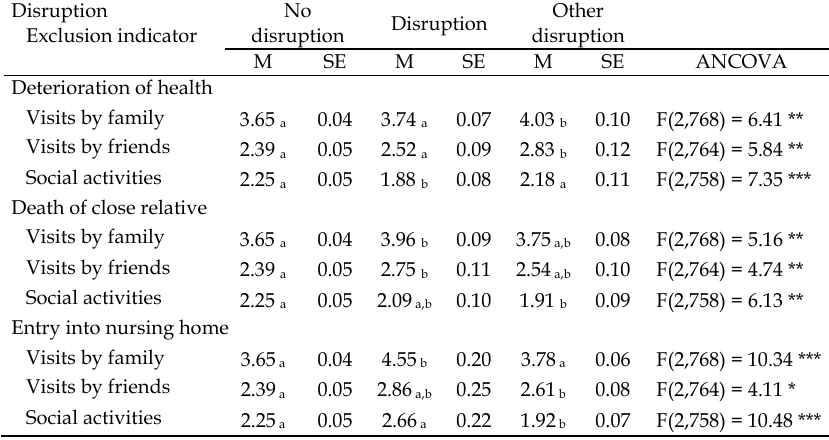
Table 3 . Adjusted means, standard errors and analysis of